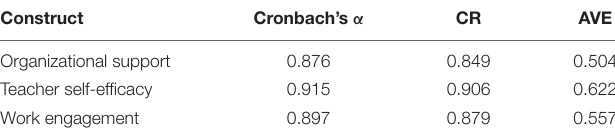
TABLE 2 | Results of confirmatory factor analysis.